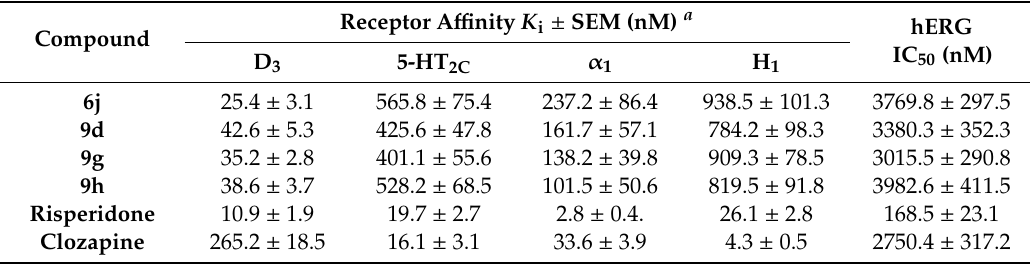
Table 3. Activities on D 3, 5-HT 2C , α 1 and H 1 Receptors of compounds and reference